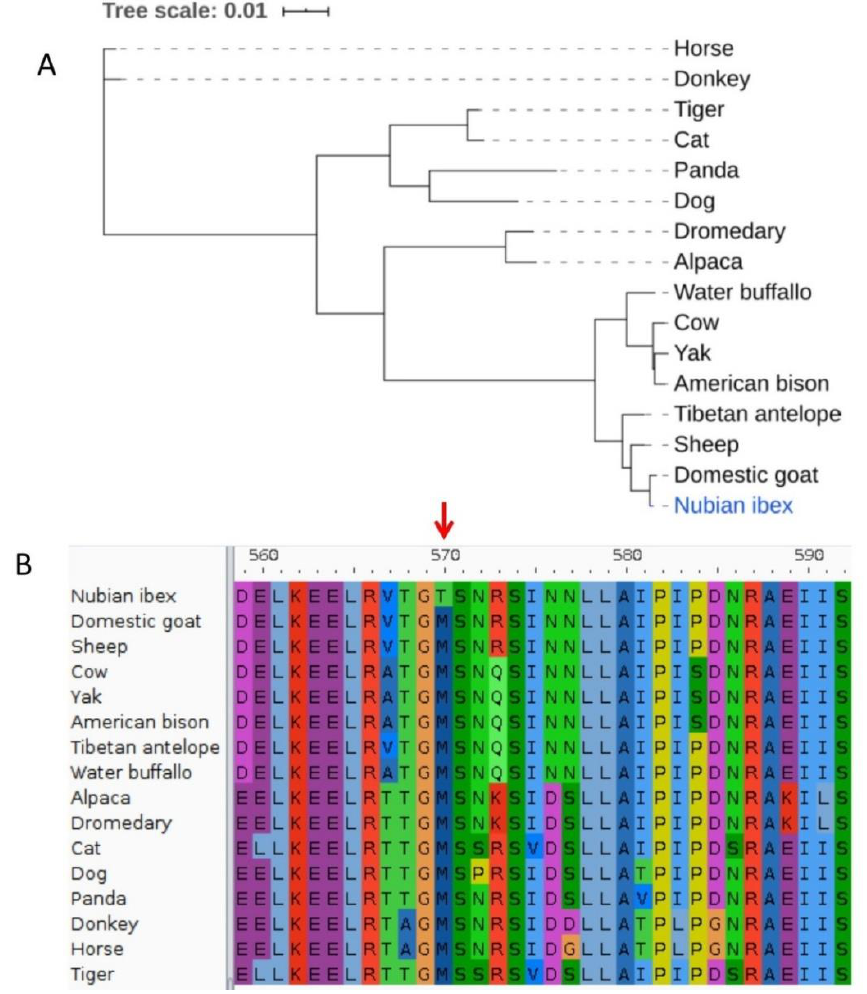
Figure 1. An illustration of the ATP binding cassette subfamily A member 12 ( ABCA12 ) phylogeny tree and alignment data used for dN/dS analysis. ( A ) The maximum likelihood phylogenetic tree from ABCA12 amino acid sequences of 16 species used for dN/dS analysis. ( B ) The multiple sequence alignment of the 16 species used of dN/dS analysis showing amino acid site (M570T) under positive selection in ABCA12 gene.